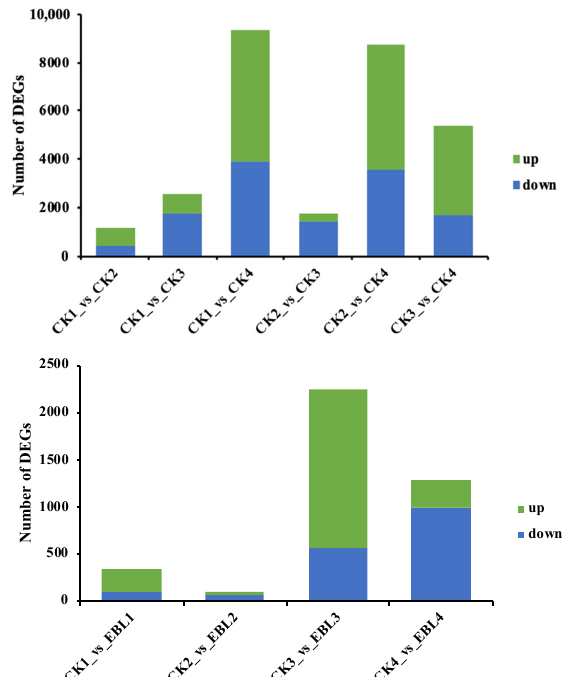
Int. J. Mol. Sci. 2022 , 23 , x FOR PEER REVIEW Figure 7. Number of upregulated and downregulated unigenes under EBL5 at four sampling times. Here, we performed a Venn analysis to obtain the co-expression genes in all samples and the specific expression genes in each sample. As described in Figure 8, the number of co-expression genes among all samples was 21,595. The number of specific expression genes in CK showed an ‘upward-downward-upward’ trend during seed development, with the lowest number at 100 DAF (1033) and the highest number at 130 DAF (5510). As for the number of specific expression genes in seeds from EBL5-treated trees, the mini- mum and the maximum were found at 50 DAF and 130 DAF, respectively. Except at 70 DAF, EBL5 contained more specific expression genes than that in CK in the same period. Overall, the number of unigenes within each treatment fluctuated moderately from 50 DAF to 100 DAF, while the dynamic became drastic at 130 DAF.